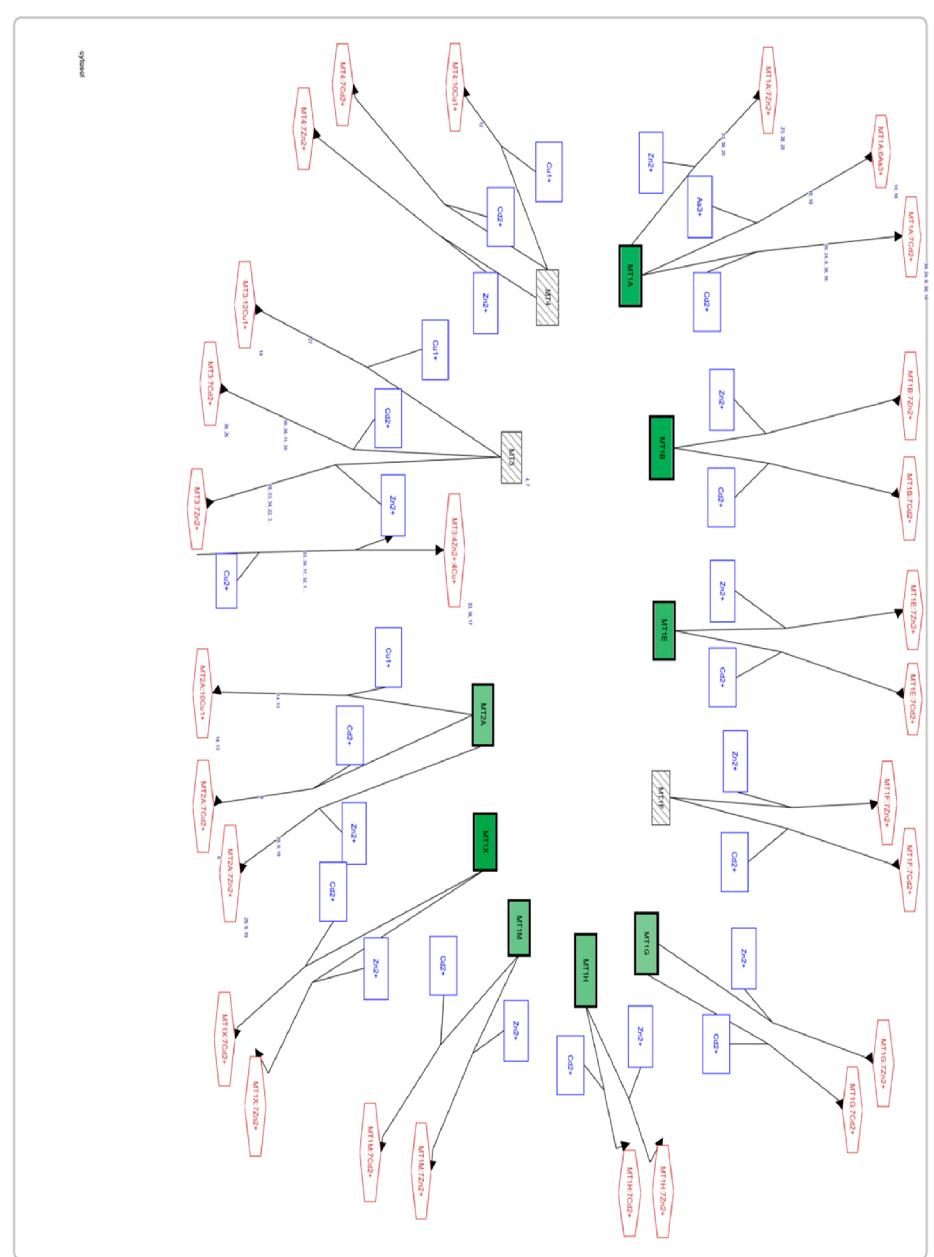
Figure 5. Screenshot of the Affymetrix Microarrays program on the metabolic pathway of the metallothioneins. Differences in genetic expression between the study groups are indicated, using the -PD-FI group as a control. Those genes that are downregulated are shown in green, upregulated genes (none are to be seen in the image) are in red, and genes with unaltered expression are in striped gray).